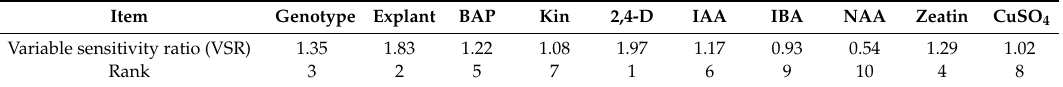
Table 3. The results of sensitivity analysis on the developed GRNN model to rank the importance of factors involved in in vitro shoot regeneration of